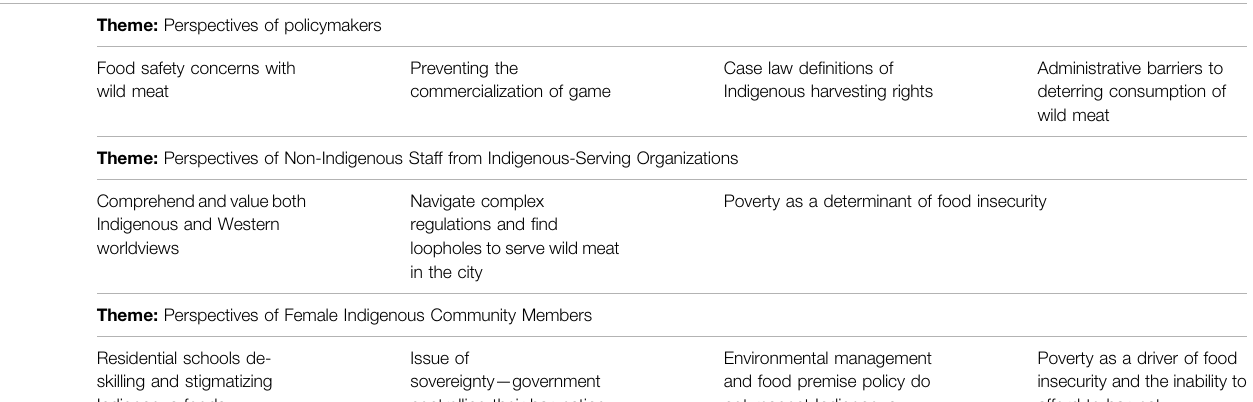
Theme: Perspectives of